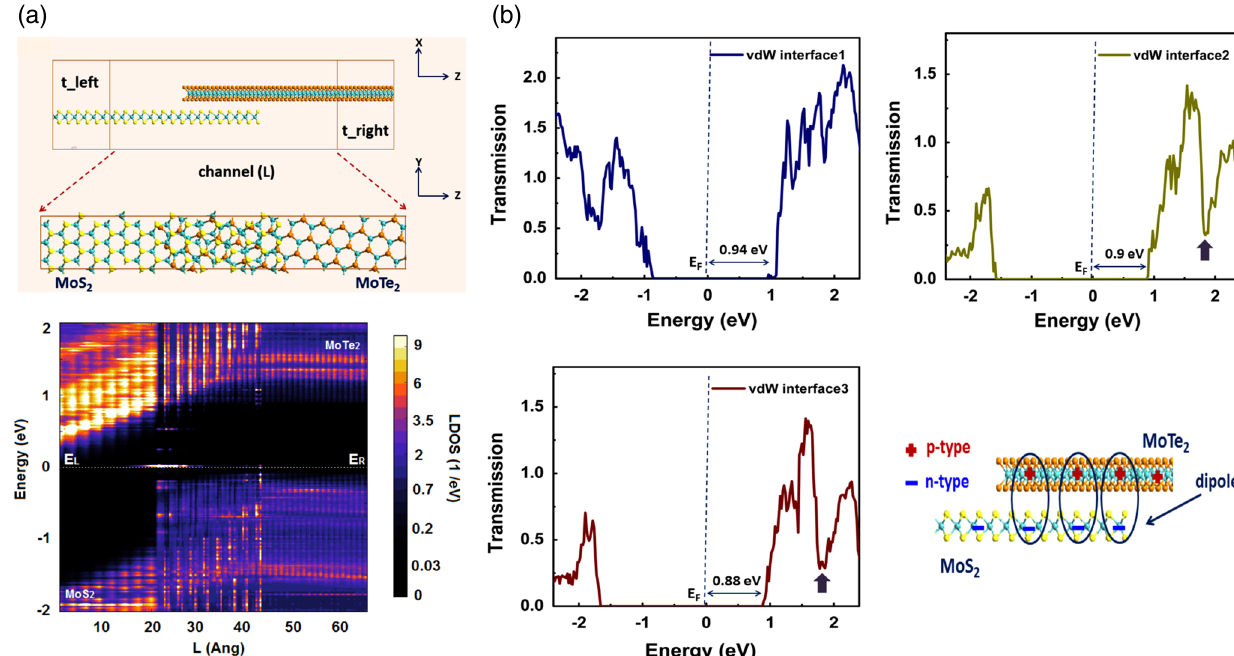
Fig. 6 a ( top ) MoTe 2 – MoS 2 vdW interface, where length of the channel is ~6.6 nm and width is ~1 nm. ( bottom ) Energy-position resolved LDOS diagram for the vdW interface3. b Transmission spectra of vdW interface1 ( upper left ), vdW interface2 ( upper right ), and vdW interface3 ( bottom left ). ( bottom right ) The schematic illustrates the formation of electric dipoles along the Figure 6b illustrates the zero bias transmission spectra of the MoS